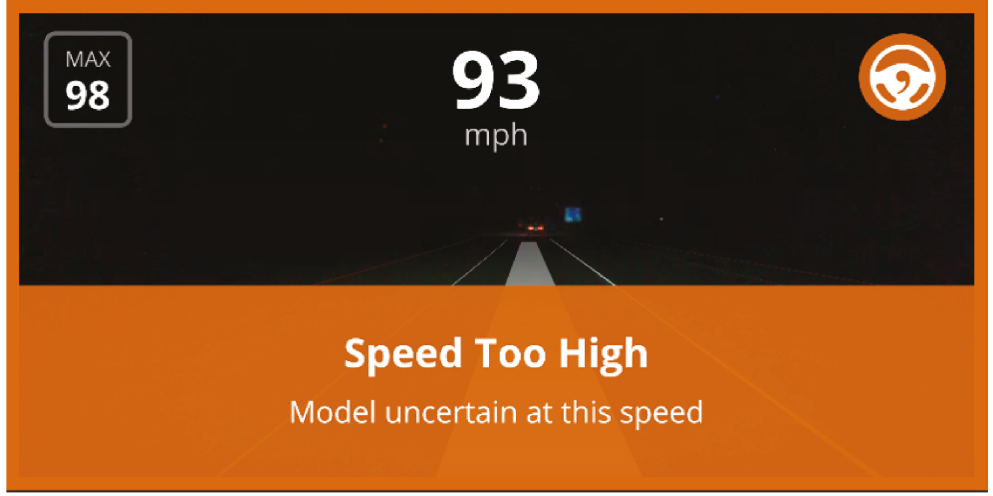
Figure 61: Speed Too High